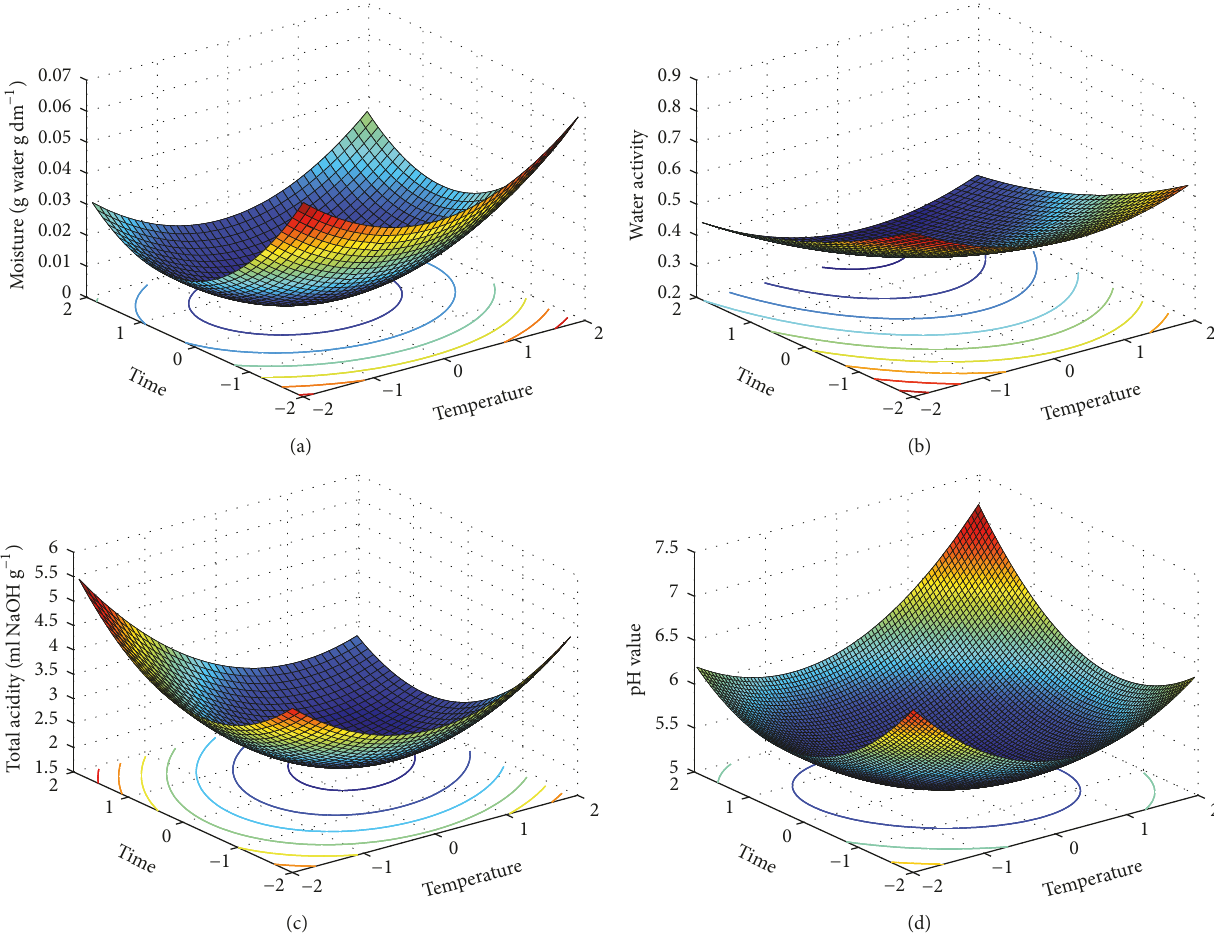
Figure 1: The surface plots of moisture (a), water activity (b), total acidity (c), and pH (d) as affected by roasting time and temperature.